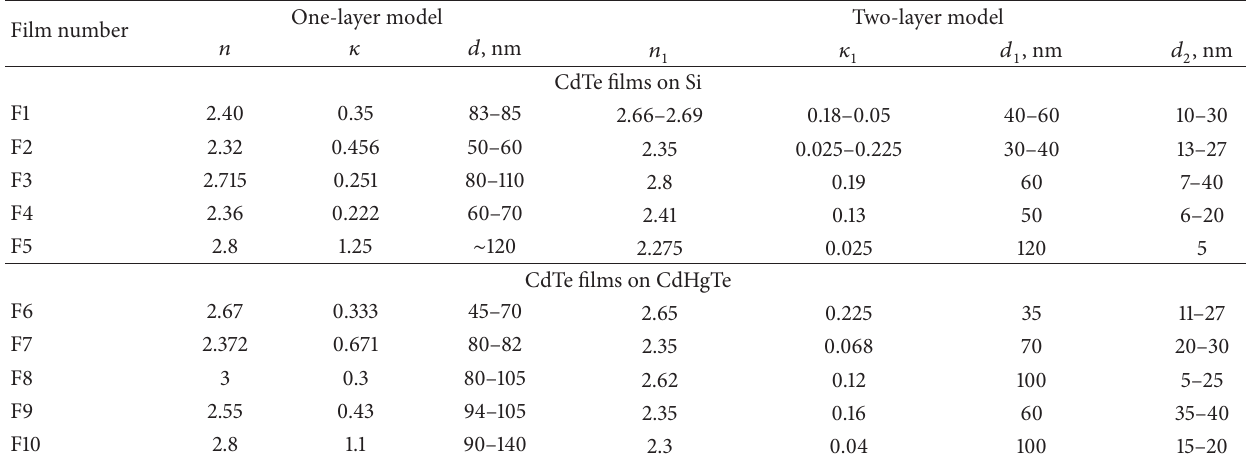
Table 2: Refractive index 𝑛 , index of extinction 𝜅 , and CdTe film thickness 𝑑 , calculated using the one-layer model; refractive index 𝑛 1 , index of extinction 𝜅 1 , and thickness 𝑑 1 of the outer layer and thickness 𝑑 2 of the inner layer, calculated using the two-layer model ( 𝜆 = 632.8